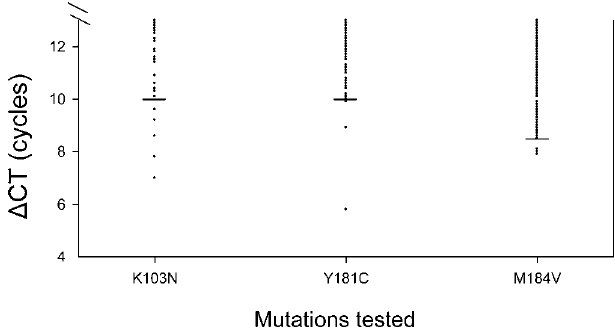
Figure 4. Real-Time PCR Mutation Test Results ( D CT) for Three Treatment-Relevant Mutations in the Case-Control Study Group Horizontal bar (—) denotes the assay cutoff for the mutation. Samples falling below this bar are positive for the mutation.